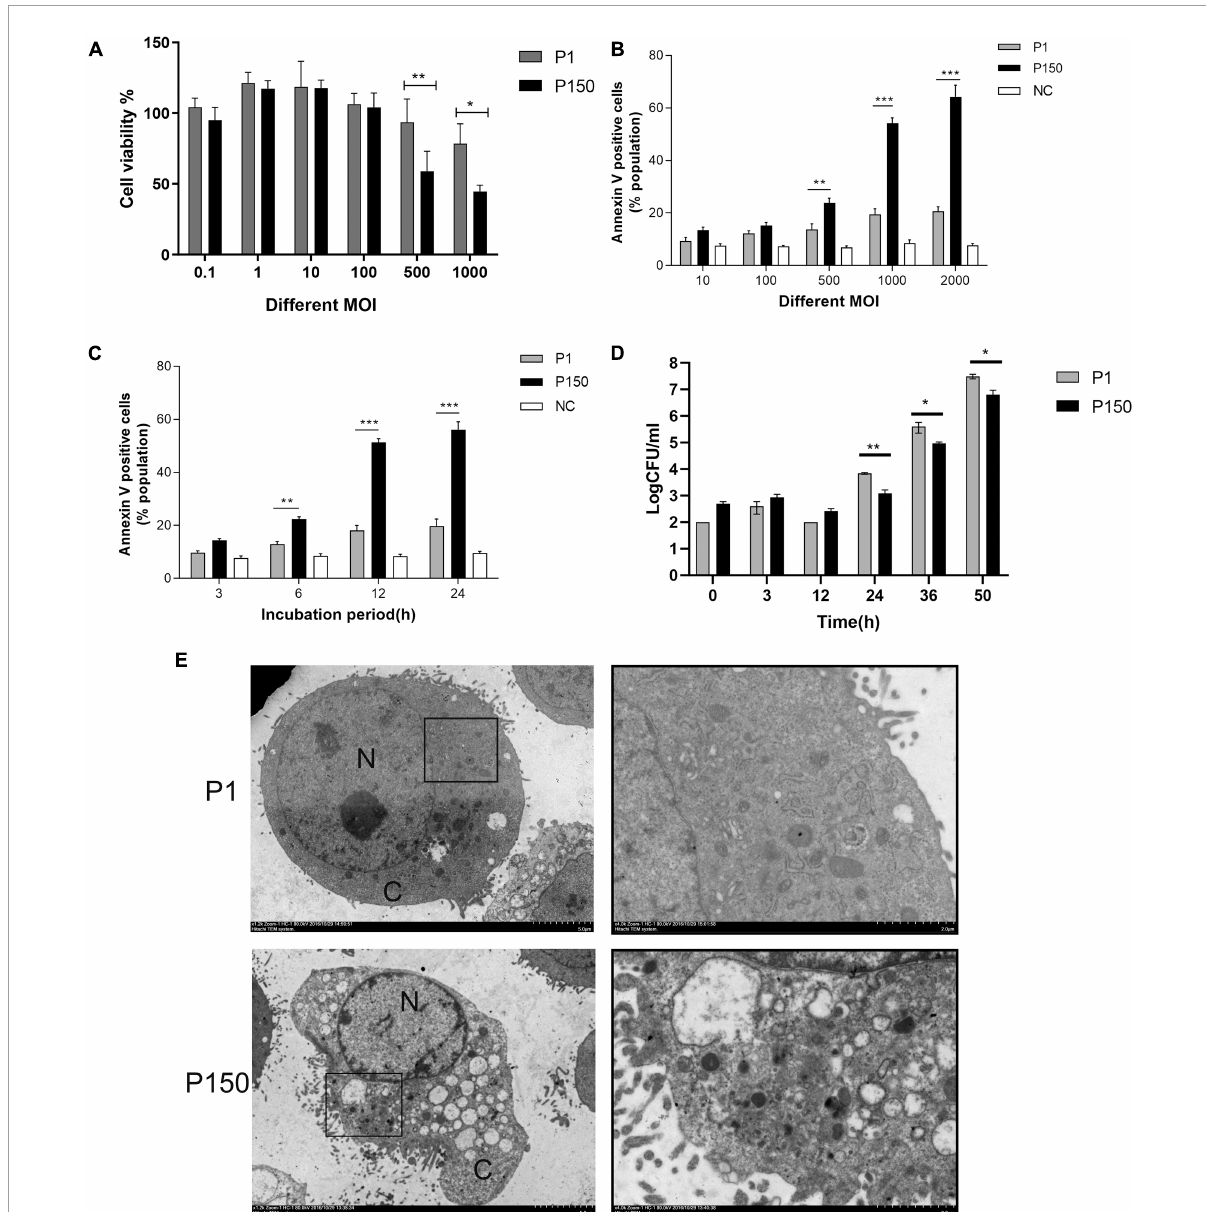
FIGURE1 The differential viability and apoptosis of BoMac cells infected by M. bovis P1 and P150 and intracellular survival of both strains. (A) MTT assay demonstrated that infection decreased cell viability in dose-dependent manner with the high multiplicities of infection (MOI) of 500 and 1000, but P150 showed stronger ability to reduce cell viability than P1. (B) Flow cytometry assay on apoptosis of the infected BoMac cells at various MOIs after being stained with Annexin V-FITC and propidium iodide (PI) showed that P150 induced significantly higher levels of apoptosis at high MOIs. (C) Flow cytometry assay on apoptosis of infected BoMac cells at various times post-infection at an MOI of 1000 showed that P150 induced significantly higher levels of apoptosis from 6 h onward. (D) Intracellular survival and growth of M. bovis P1 and P150 in BoMac cells. The data represent the mean ± SD of 3 independent experiments. *, **, and *** represent p < 0.05, p < 0.01, and p < 0.001, respectively. (E) TEM micrographs of BoMac cells infected with P1 and P150 where the P150 infected cells are characterized by typical morphology of apoptotic cells including cytoplasmic vacuolation, chromatin condensation and margination, and formation of a crescent. The perinuclear rough ER regions on the images in the left panel are magnified on the right panels. Asterisk indicates ER lamellae infection by P1 and P150. N, nucleus; C, cytoplasm.